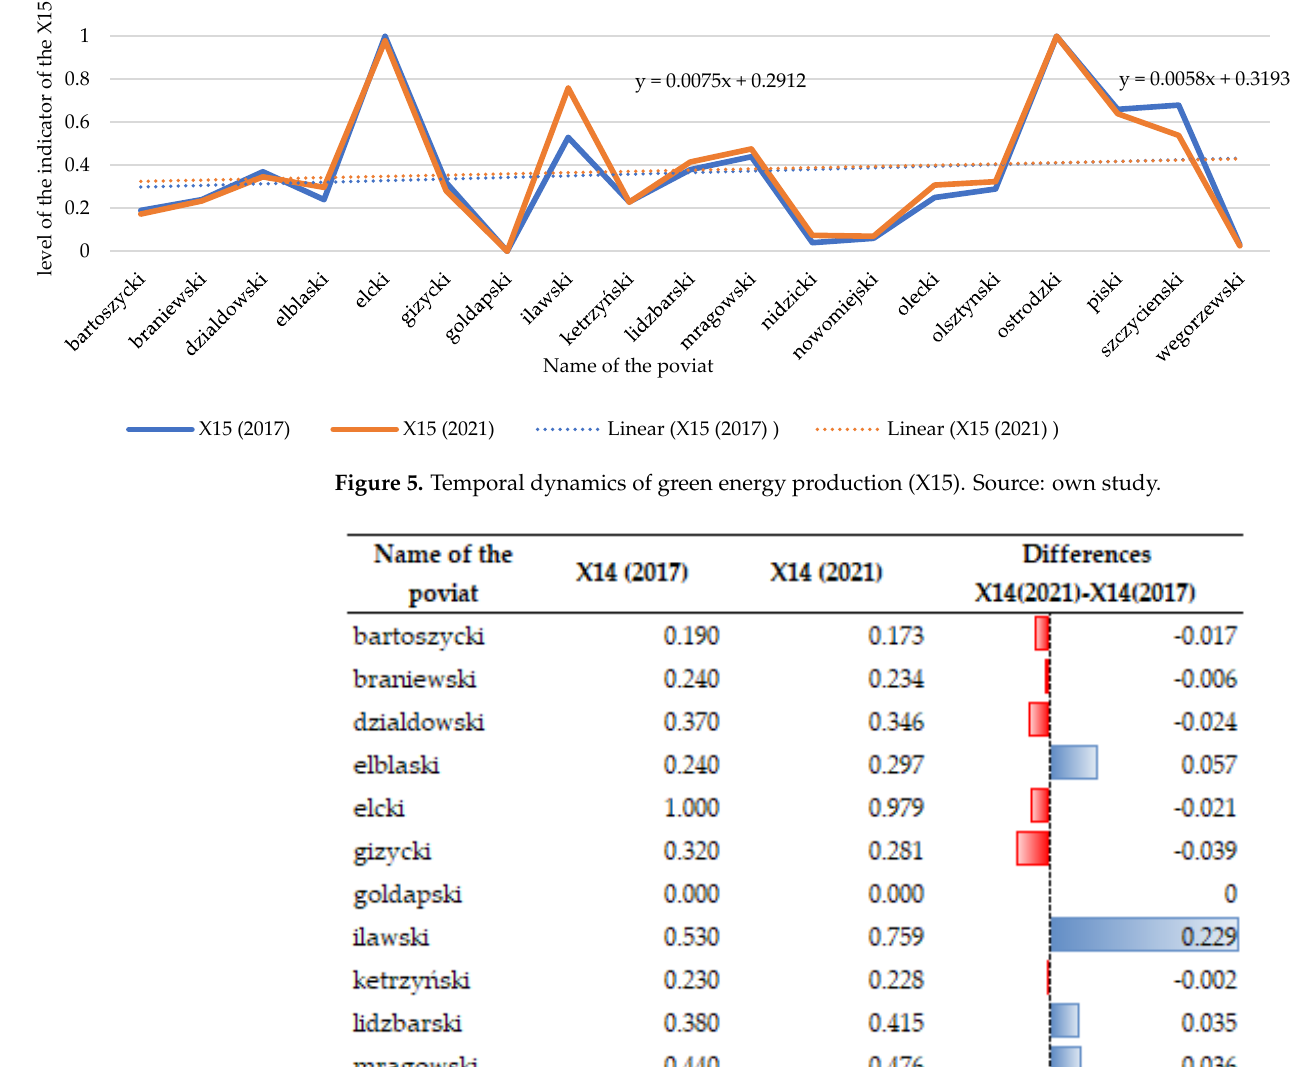
Figure 4. Changes in the index of green energy production (X15) in 2017 – 2021. Source: own study on [103].